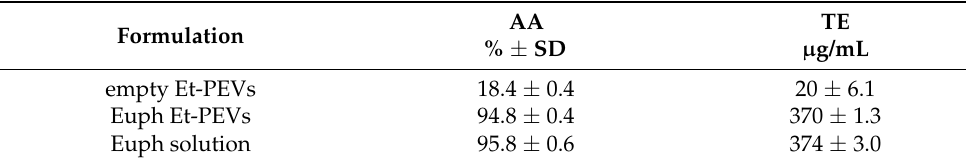
Table 4. Antioxidant activity of the vesicle formulations in comparison with an ethanol solution of the E. characias extract (Euph). DPPH results are expressed as Antioxidant Activity (AA) and as Trolox Equivalents (TE). Results are reported as the mean value ± SD of 3 separate experiments, each performed in triplicate.